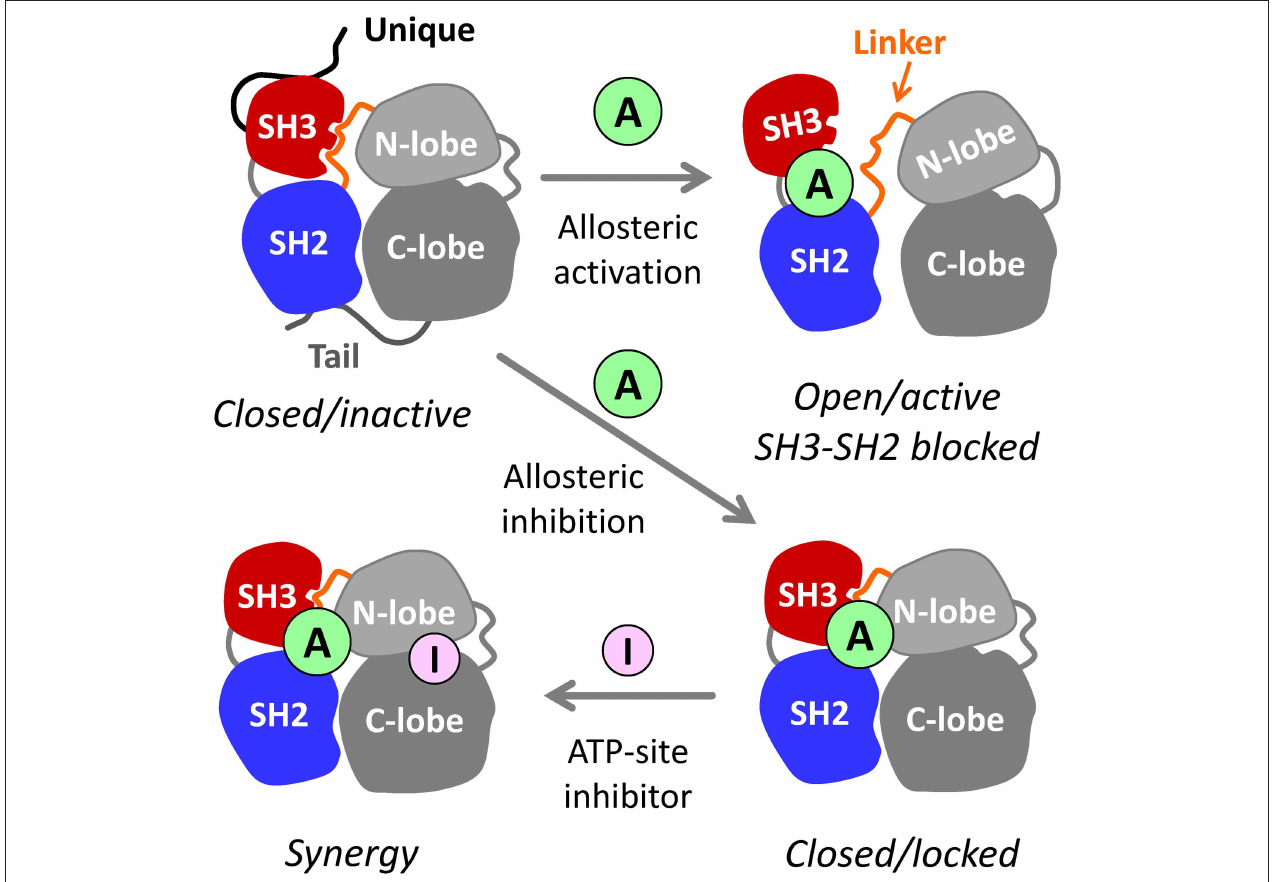
FIGURE 1 | Allosteric modulators of Src-family kinases. Hck, Fgr, and other Src-family kinases are regulated by intramolecular interactions of their SH3, SH2, and bi-lobed kinase domains (N- and C-lobes). The SH3 and SH2 domains pack against the back of the kinase domain to stabilize the inactive, assembled kinase conformation (upper left). Small molecule allosteric ligands (A) that bind to the SH3-SH2-linker region have the potential to disrupt its regulatory influence on the kinase domain, resulting in kinase activation (top right). Because SH3 and SH2 are also involved in trans -interactions with other proteins, small molecules that bind to this region may interfere with signaling by altering substrate recruitment. Allosteric ligands also have the potential to stabilize the closed, inactive conformation (lower right). Such compounds may inhibit the kinase directly and/or enhance the potency of existing ATP-site inhibitors (I) that prefer a particular conformation of the active site (lower left—see text for details). For simplicity, the N-terminal unique domain and regulatory C-terminal tail are shown only for the closed/inactive